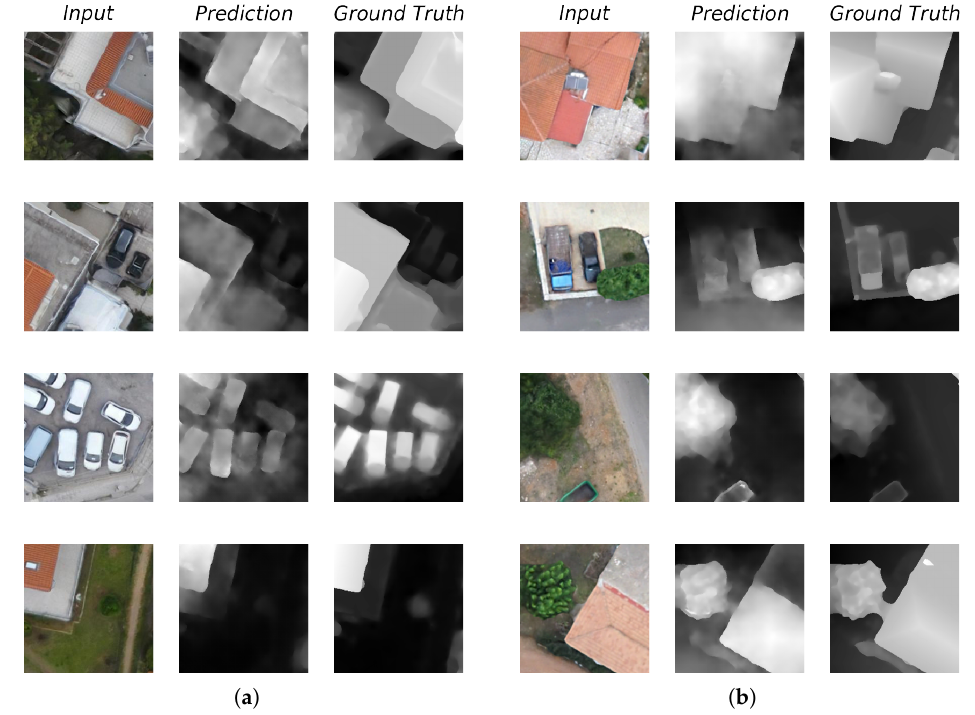
Figure 10. The generator’s results on previously unseen testing data of the ( a ) Urban and ( b ) Rural datasets. The model adequately captures the true data distribution, even though few examples are used during training. Notice that even though the ground truth DEM of the bottom row in ( b ) seems to contain an inaccuracy (the tree and the house appear connected), the generator’s prediction does not contain such an